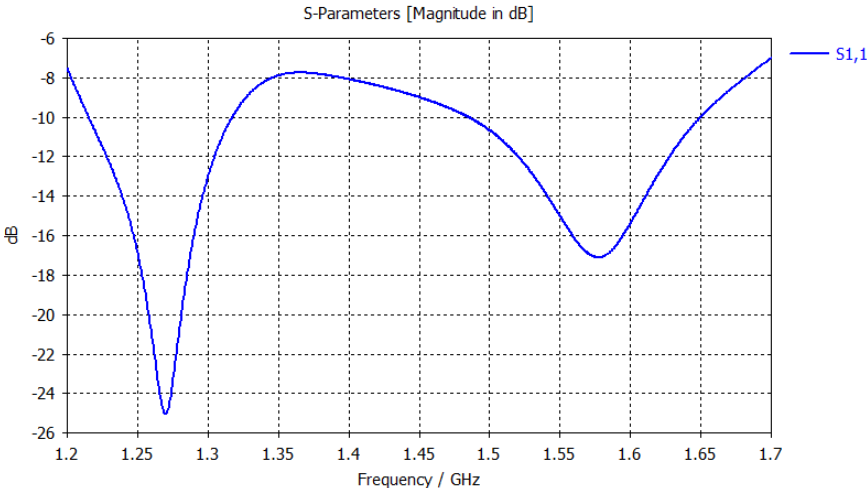
Figure 3. Radiating element simulated reflection coefficient.